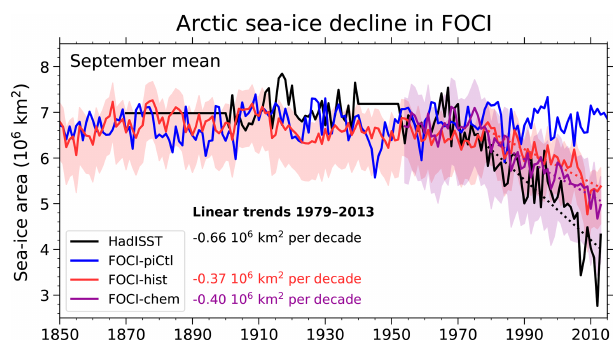
Figure 20. Total NH sea-ice area from pre-industrial control (blue) and historical simulations without (red) and with stratospheric chemistry (purple). For the latter, mean (bold lines) and range of 2 standard deviations (shading) are depicted for each small ensem- ble. The bold black line depicts the HadISST observational estimate for reference. Linear trends over the period 1979–2013 are provided next to the legend and indicated by dashed lines in respective